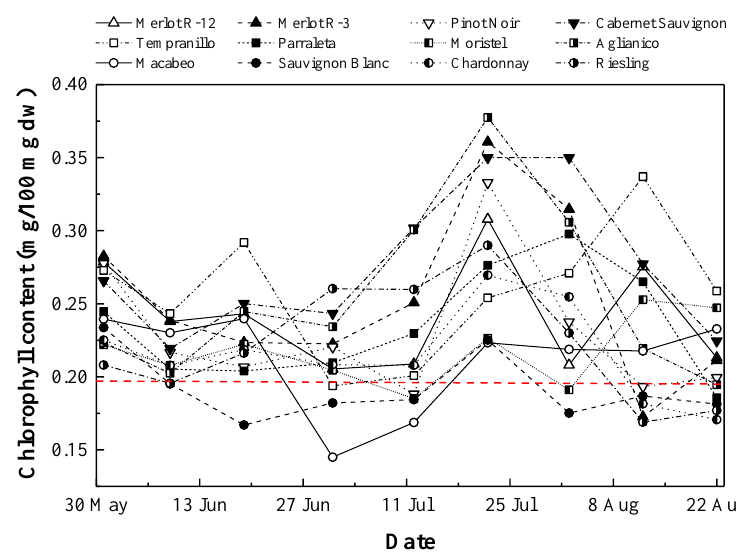
Figure 1. Evolution of chlorophyll content for the different grapevine varieties under study. Only average values are shown for clarity purposes. The level at which LIC occurs (0.198 mg/100 mg, dw) is indicated with a red dashed line.